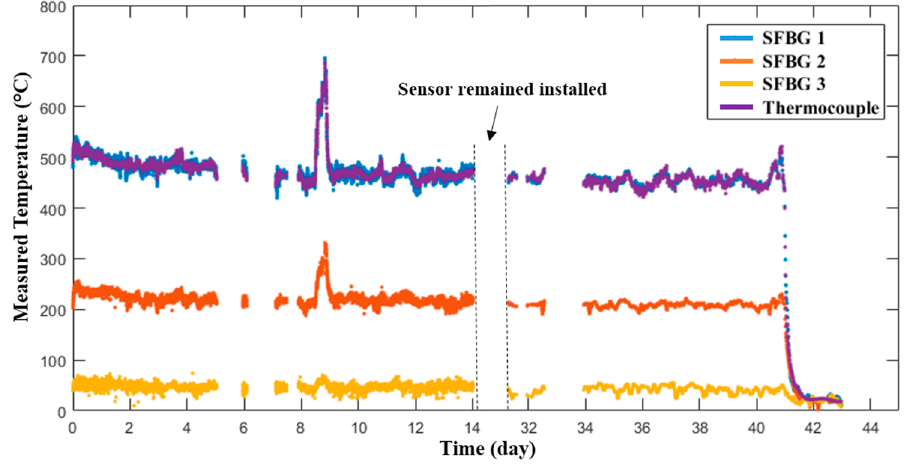
Figure 8. Temperature response of the sensor in a commercial coal-fired boiler over 42 days.